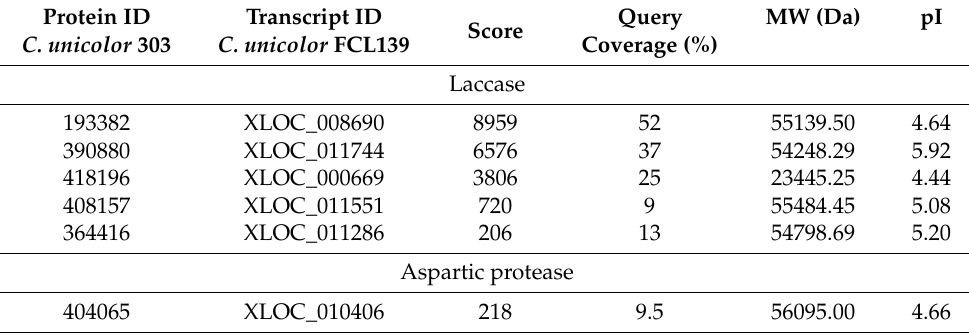
Laccases identified in the secretome of C. unicolor FCL139 by means of liquid chromatography–mass spectrometry